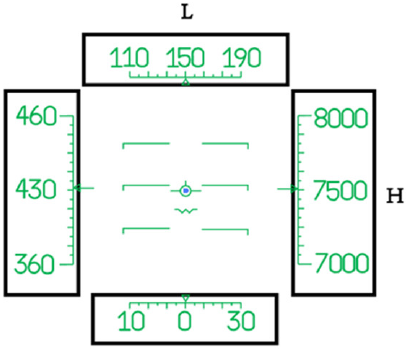
Figure 2. HWD system interface information layout design.